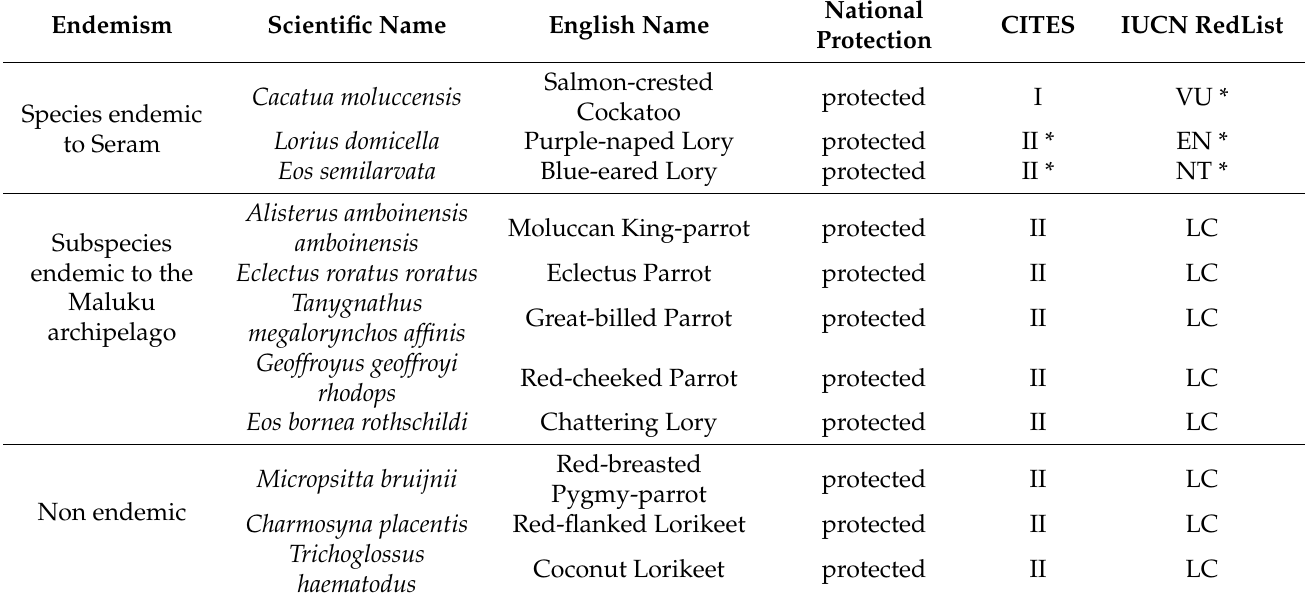
Table 1. Endemism and conservation status of the parrot fauna in Seram, Indonesia. Presented are endemism, scientific and English names, national protection [3], CITES status (Appendix I or II), and IUCN Red List conservation status (LC = Least Concern, NT = Near Threatened, VU = Vulnerable, EN = Endangered) [1]. * The current study includes recommendations to change these statuses (under Section